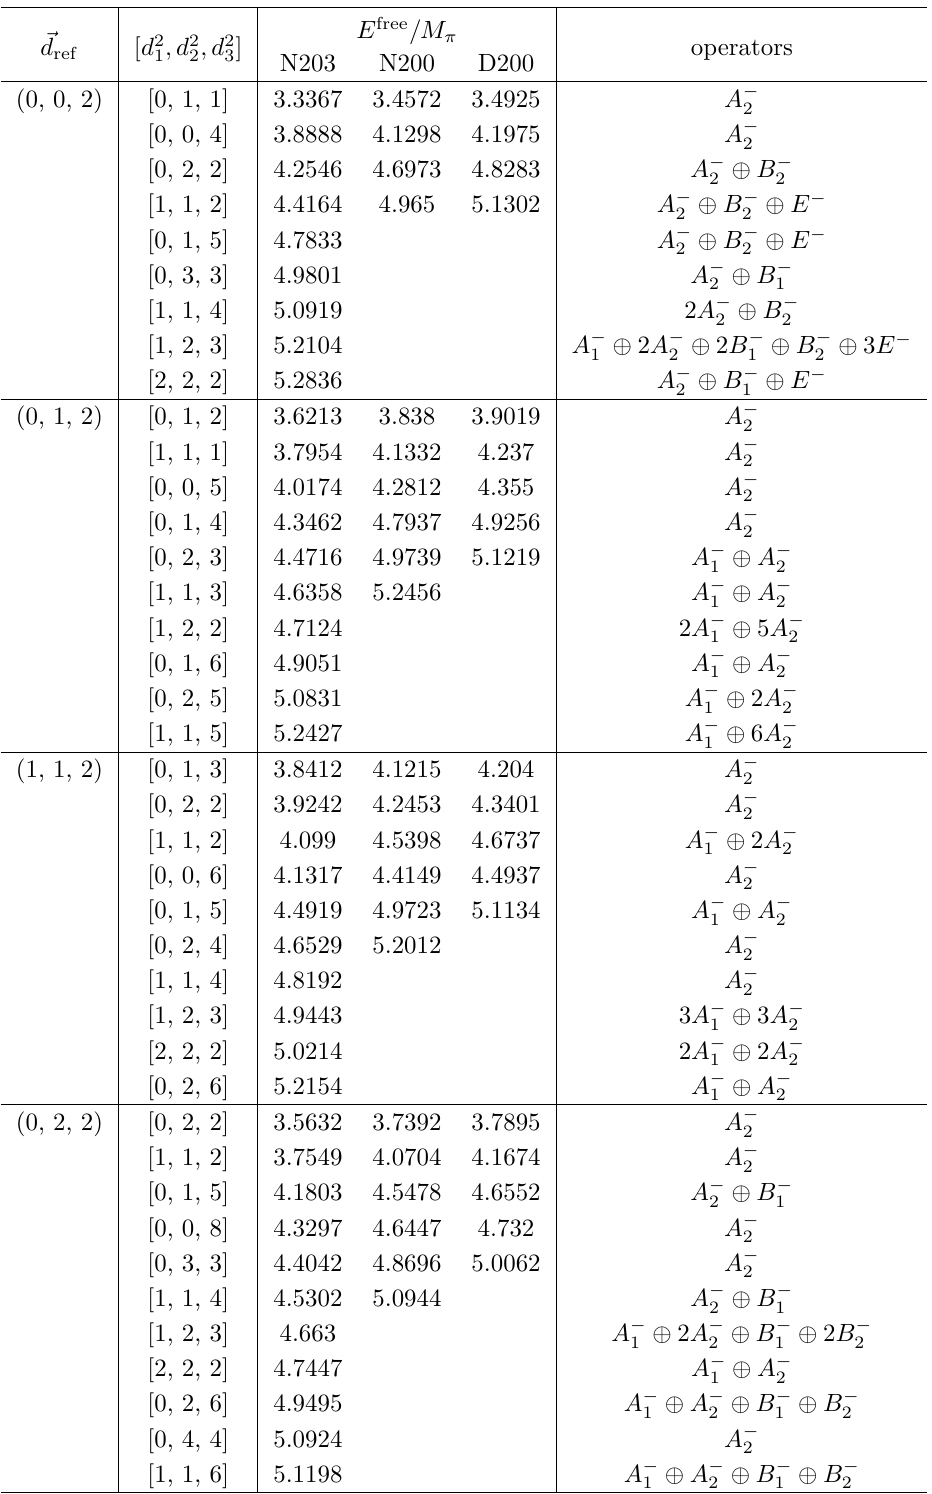
Table 22. Same as table 21 except for the three-pion operators with 4 ≤ ~d 2